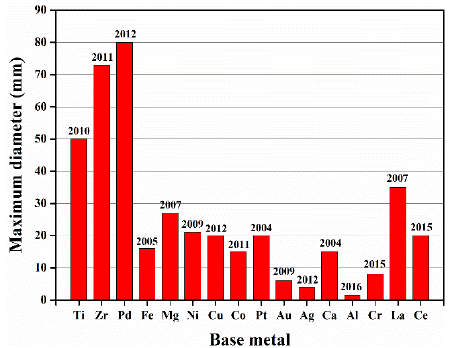
Figure 1. Maximum diameters of the bulk metallic glass (BMG) rods achieved in different alloy systems and the years in which they were discovered. Data are taken from [8,58–73].